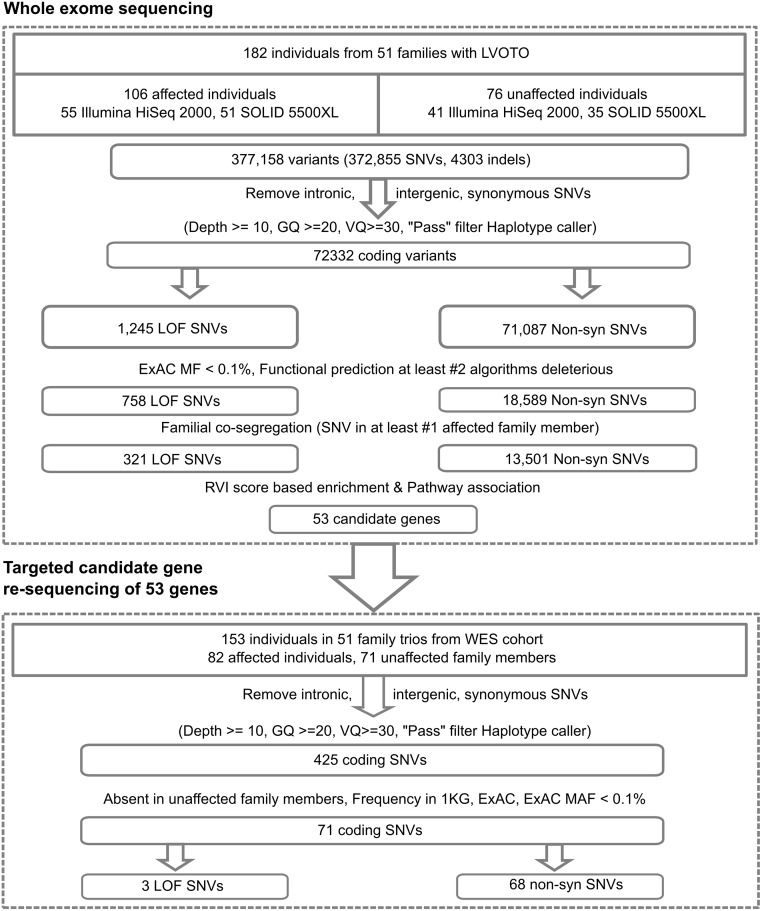
Variant filtering criteria and candidate gene prioritization.Variants were called using the GATK pipeline as outlined in the method section. Several stringent quality and allele filtering thresholds were applied prior to filtering for allele frequency and co-segregation among family members. Annotation and filtering of coding SNVs was performed using the ANNOVAR pipeline for RefSeq gene annotations [65].